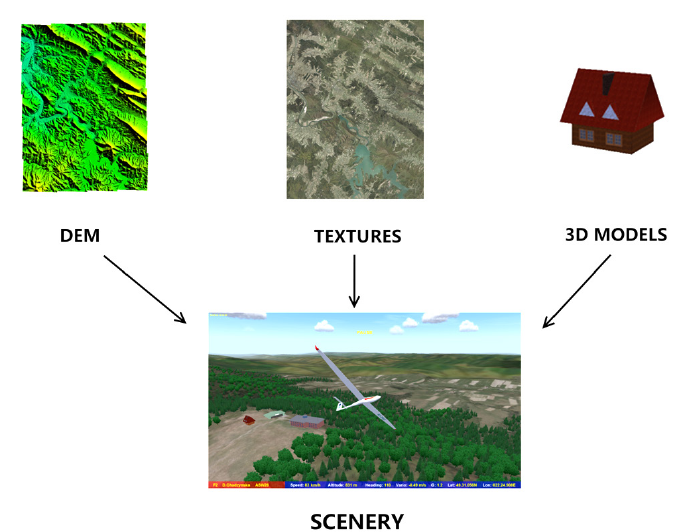
Fig. 8. Scenery components creating a model of space in the “Condor”